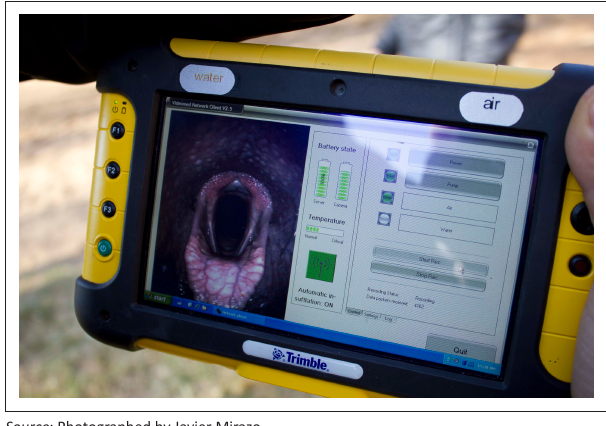
FIGURE 4: Wireless console showing laryngeal function.